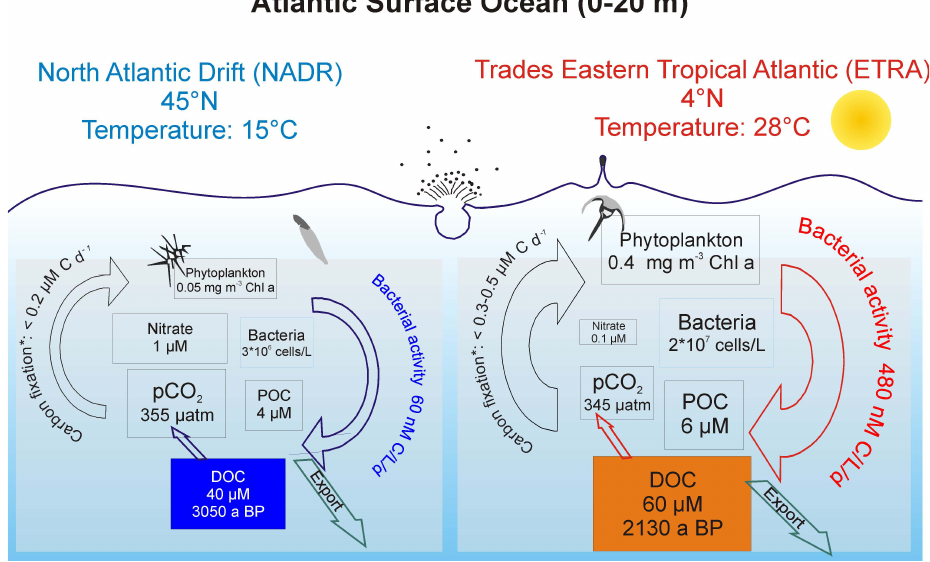
Fig. 4. Schematic overview of important variables which were measured during the ANT-XXV/1 cruise and which were related to the DOC distribution and molecular characteristics of DOM in the surface ocean. Values are given as averages for the upper 20m of the water column at 45 ◦ N and 4 ◦ N. *Data taken from Poulton et al.,